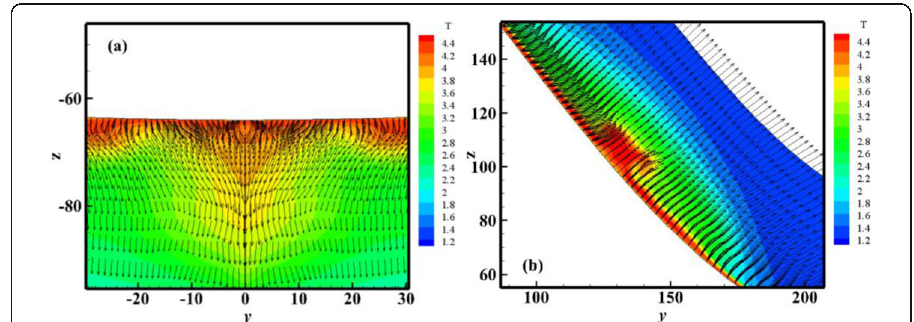
Fig. 13 The velocity vector illustration of zone 1 and 4 at x = 1400